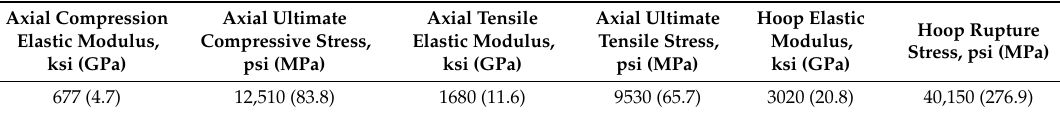
Table 1. Mechanical properties of the glass fiber-reinforced polymer (GFRP) tube.